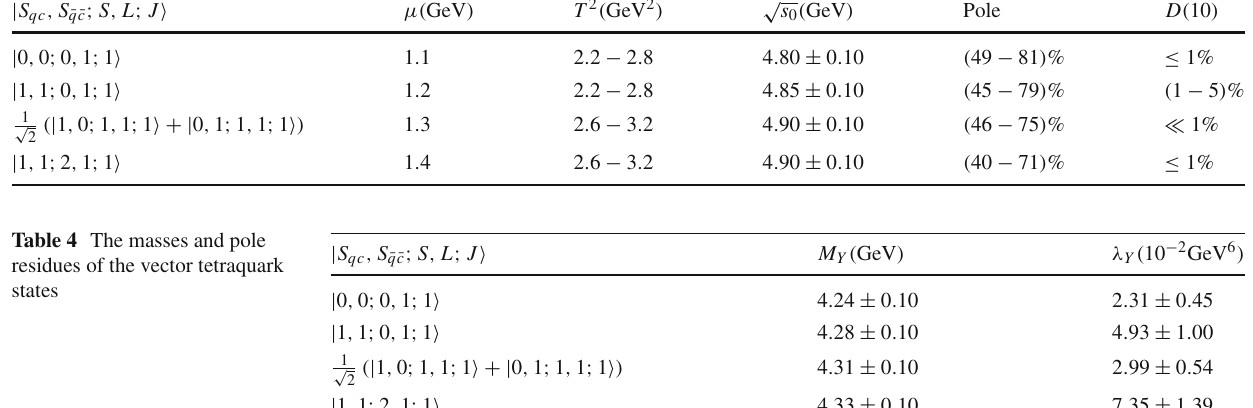
Table 3 The Borel windows T 2 , continuum threshold parameters s 0 , ideal energy scales of the QCD spectral densities, pole contributions of the ground states, and contributions of the vacuum condensates of dimension 10